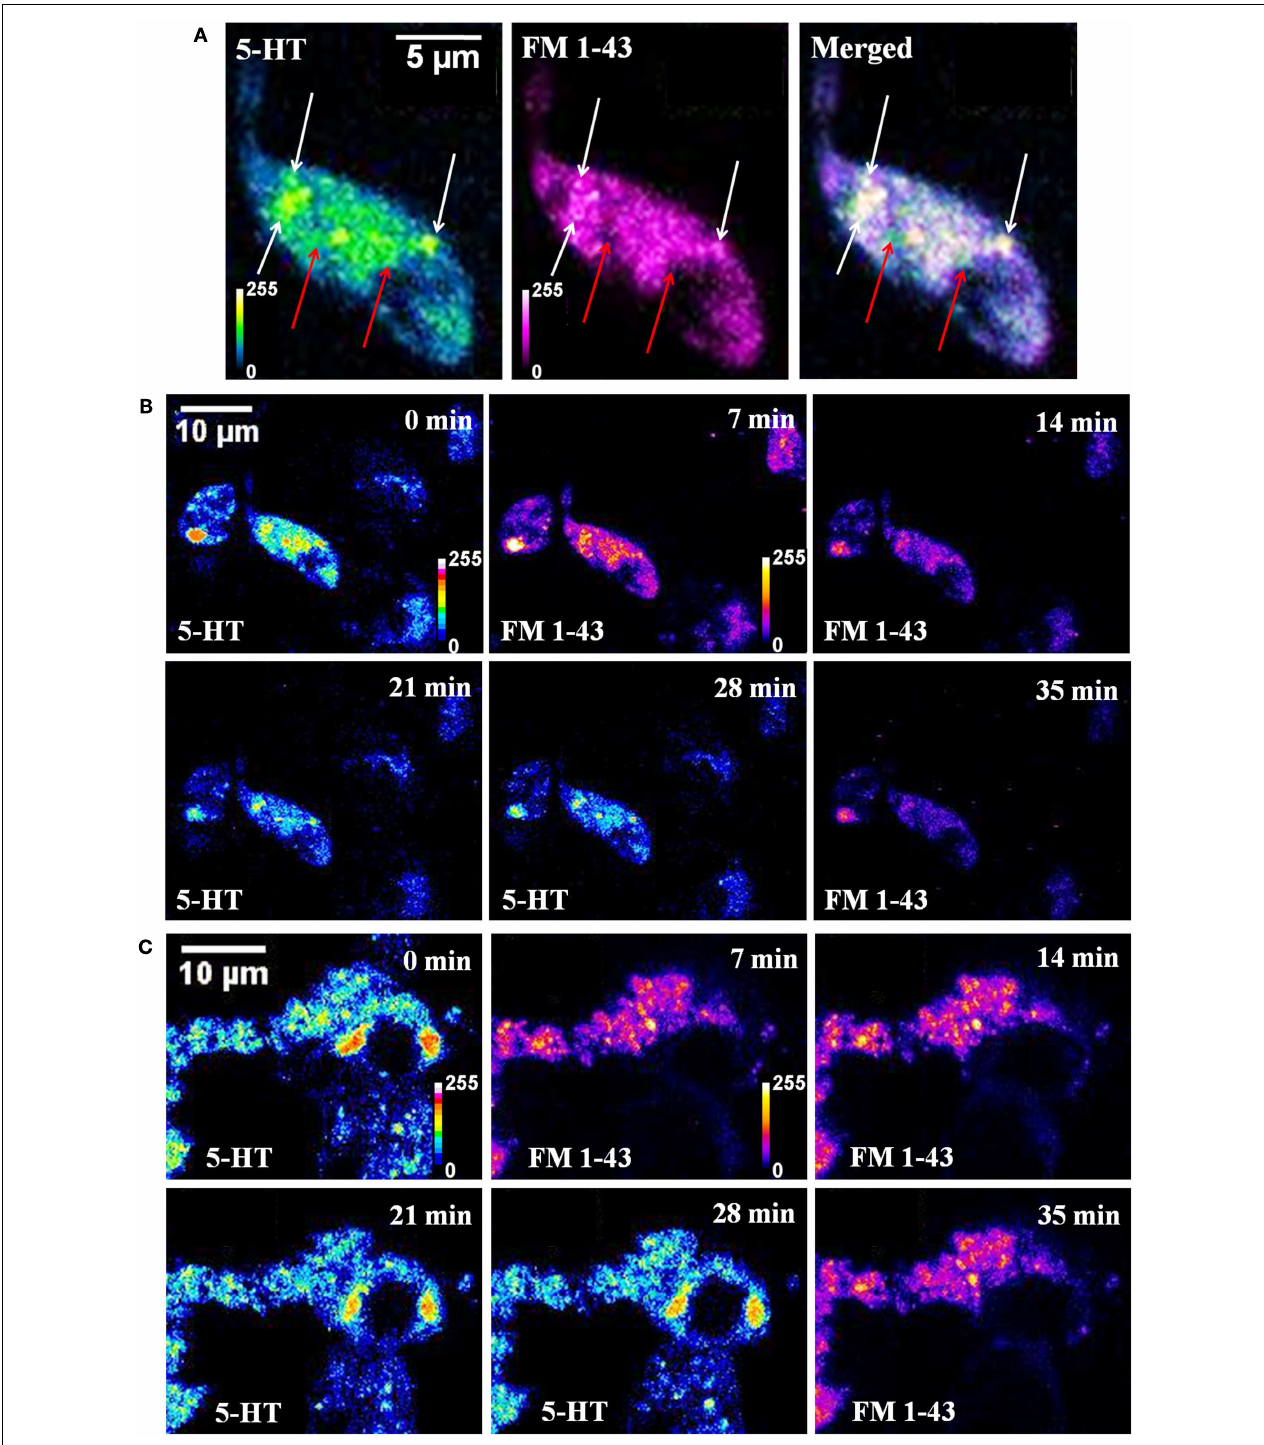
serotonin channel only. (B,C) Time lapsed quasi-simultaneous imaging of serotonin (5-HT) and FM 1-43 in depolarized (B) and sham-treated control cells. (C) Top right corner of each image shows the starting time of image recording following treatment. All image intensities are false color